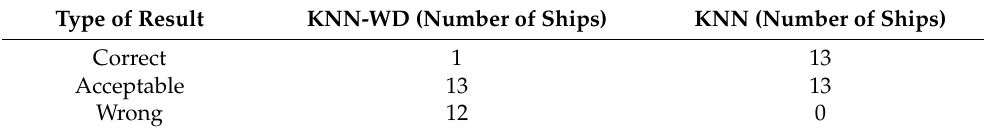
Table 6. Results of the